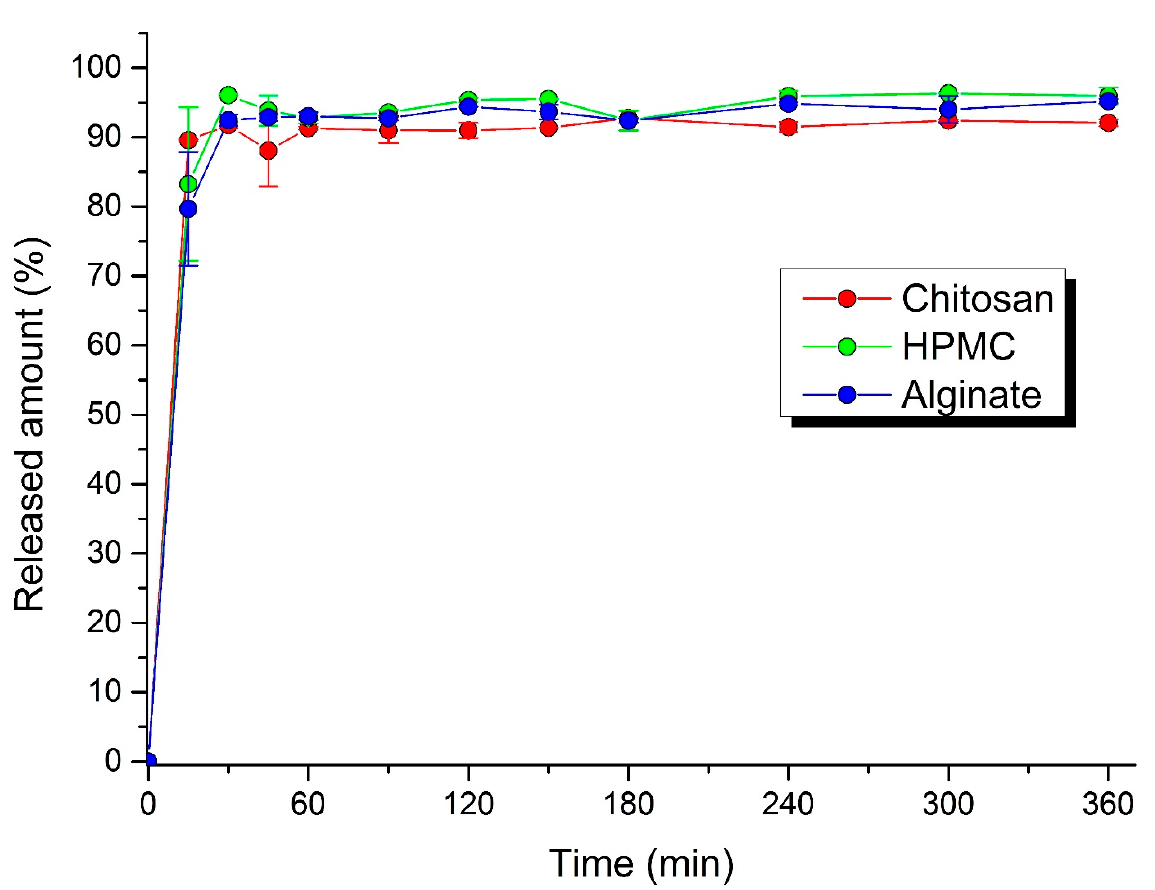
Table 7. The difference factor (f1) and the similarity factor (f2) comparing the reference (R) versus the tested (T) formulation (R/T).